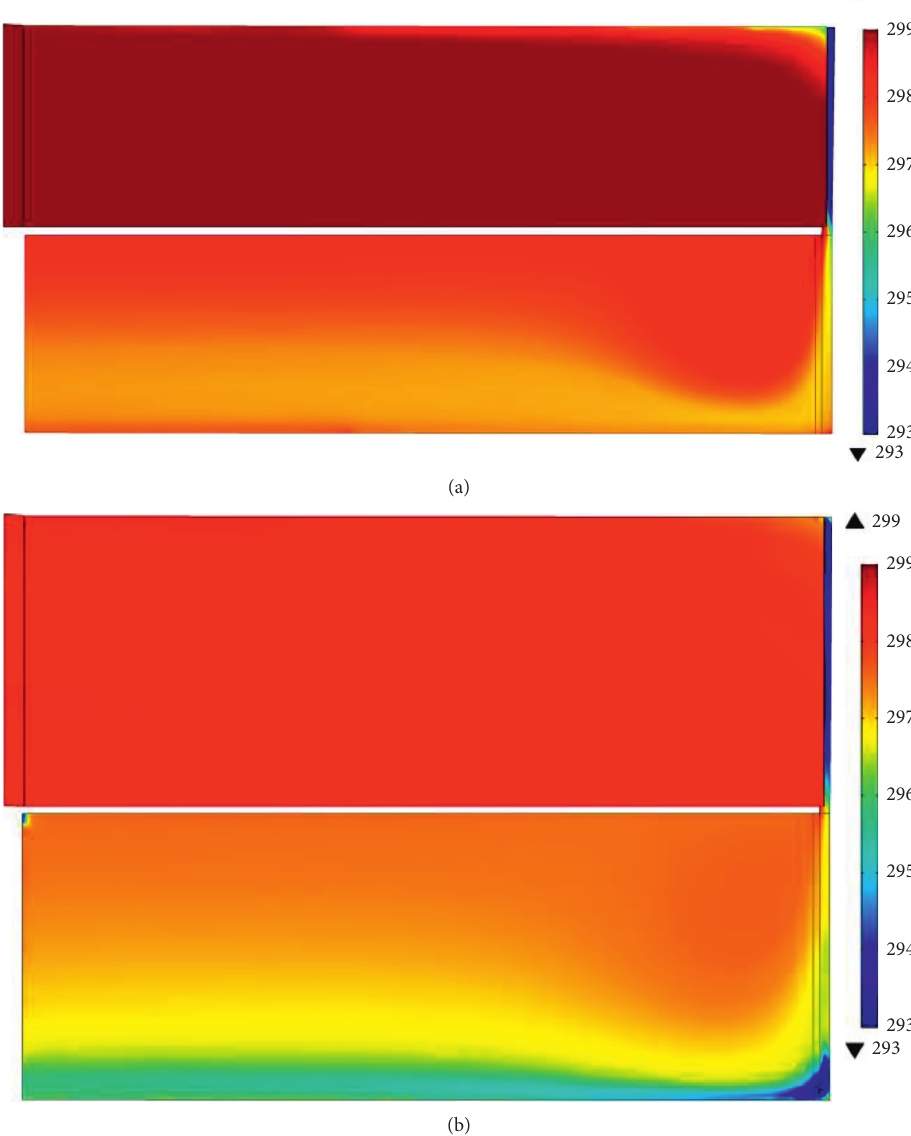
Figure 7: Effect of aspect ratio on air-water surface temperature distribution K for reactor inclined at 1 ° , Re � 9000, and water depth � 5.6mm for (a) aspect ratio � 180 and (b) aspect ratio � 340 in June